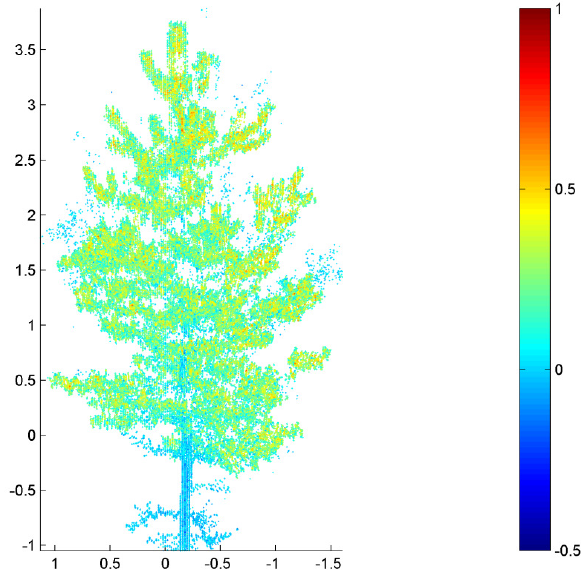
Figure 4. A 3D distribution of the Modified Triangular Vegeation Index 2 (MTVI2) over the pine sample. This index is correlated to the leaf area index (LAI).